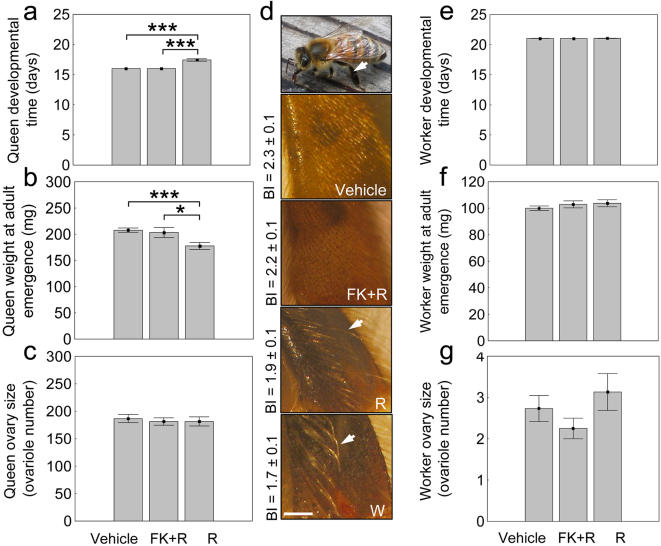
Effect of rapamycin/FK506 pharmacology on caste characters in honey bees (Vehicle = 2% ethanol in insect saline; FK+R = sequential treatment of FK506, rapamycin; R = rapamycin; W = worker as comparison).In queen-destined individuals, rapamycin: a, prolonged development and b, reduced wet-weight (size) at adult emergence; c, ovary size was not affected by pharmacology but rapamycin d, induced the worker-specific trait corbicula (arrow in top panel shows location on hind leg); pictures of hind leg basitarsus covered with short hairs in Vehicle and FK+R, and by long corbicular hairs (e.g. arrows) in R and W (scale bar 0.25 mm). Corbicula is associated with low basitarsus length/width ratio [9], and in accord R individuals showed a decrease in this Basitarsal Index (BI) mean±s. e. noted in d (ANOVA: F
3,21 = 21.48, P<0.00001, Fisher LSD: P<0.00001; vs. between Vehicle and FK+R controls and between worker-destined groups P>0.50). e–g, rapamycin/FK506 pharmacology did not affect worker-destined bees. Bars are means±s. e. (asterisk P<0.02, two asterisks P<0.005, three asterisks P<1.0 10−6).